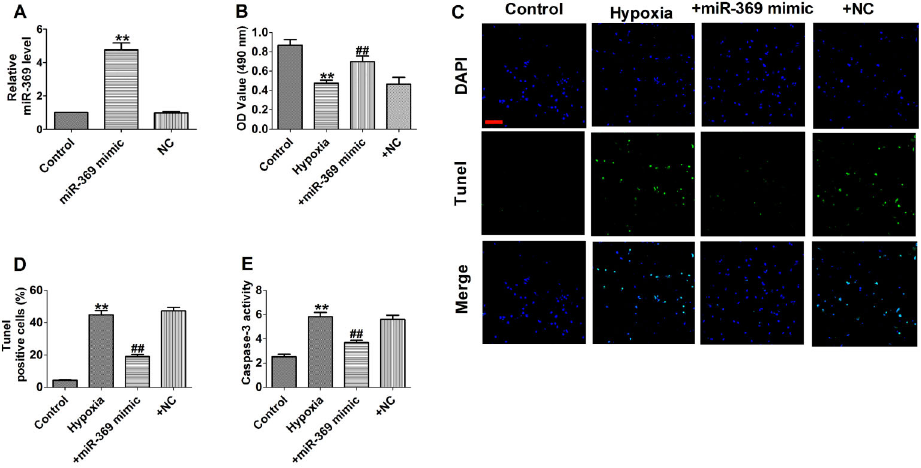
Figure 2. A , The relative mRNA level of miR-369 (n=6). B , MTT assay (n=6). C , Representative images of TUNEL staining of cardiomyocytes showing the apoptotic cells (100 (cid:2) ; scale bar, 100 m m). D , Statistical results of TUNEL-positive cells per fi eld (n=4). E , Caspase-3 activity (n=6). Data are reported as means ± SE. **P o 0.01 vs control group; ## P o 0.01 vs hypoxia group (ANOVA). NC: negative control.